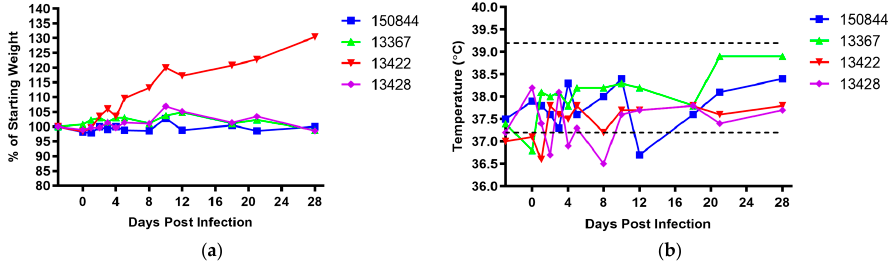
Figure 3. Weight change and rectal temperatures. Following anesthesia on specified days ( − 3, 0, 1, 2, 3, 4, 5, 8, 10, 12, 18, 21, and 28 dpi), animals were ( a ) weighed and ( b ) rectal temperatures were taken. Weights represented by % of individual animal’s weight on the day that study commenced (3 days prior to infection). Macaque 150844 seen in blue, 13367 in green, 13422 in red and 13428 in purple. Dotted lines in ( b ) represent upper and lower bounds of the range for normal cynomolgus macaque rectal temperatures [81].